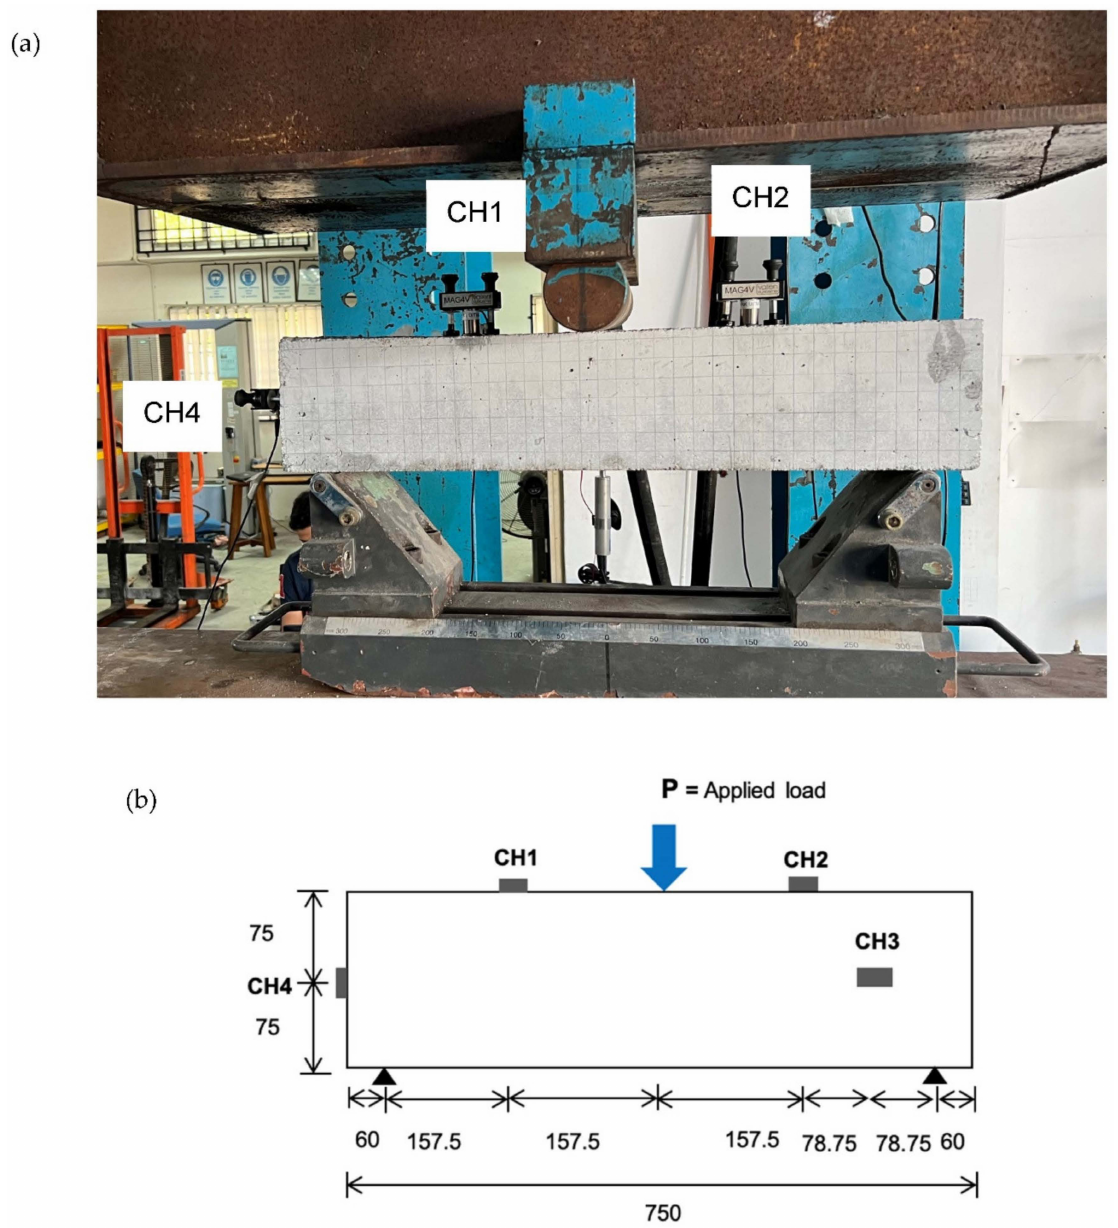
Figure 6. ( a ) Location of the acoustic emission sensor on the beam surface (one sensor, CH3 was located at back side of the beam) ( b ) Schematic diagram of the test set-up and all